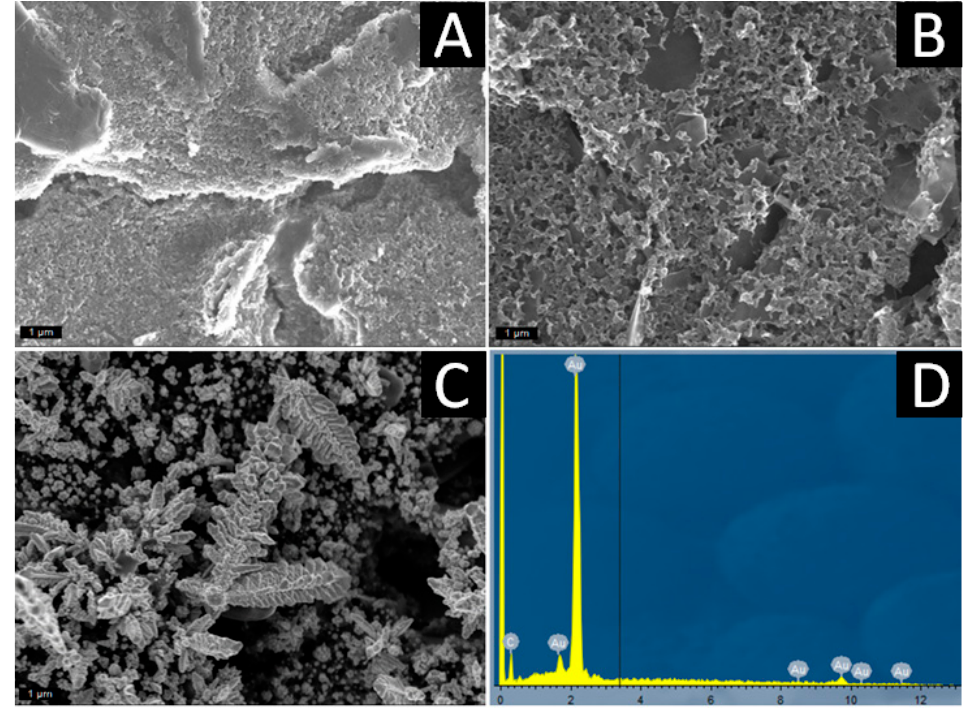
Figure 1. FE-SEM images of the working electrode surface before ( A ) and after sequential electro- deposition of GO ( B ) and AuNF ( C ). EDS spectrum for the SPE modified with GO and AuNF ( D ).